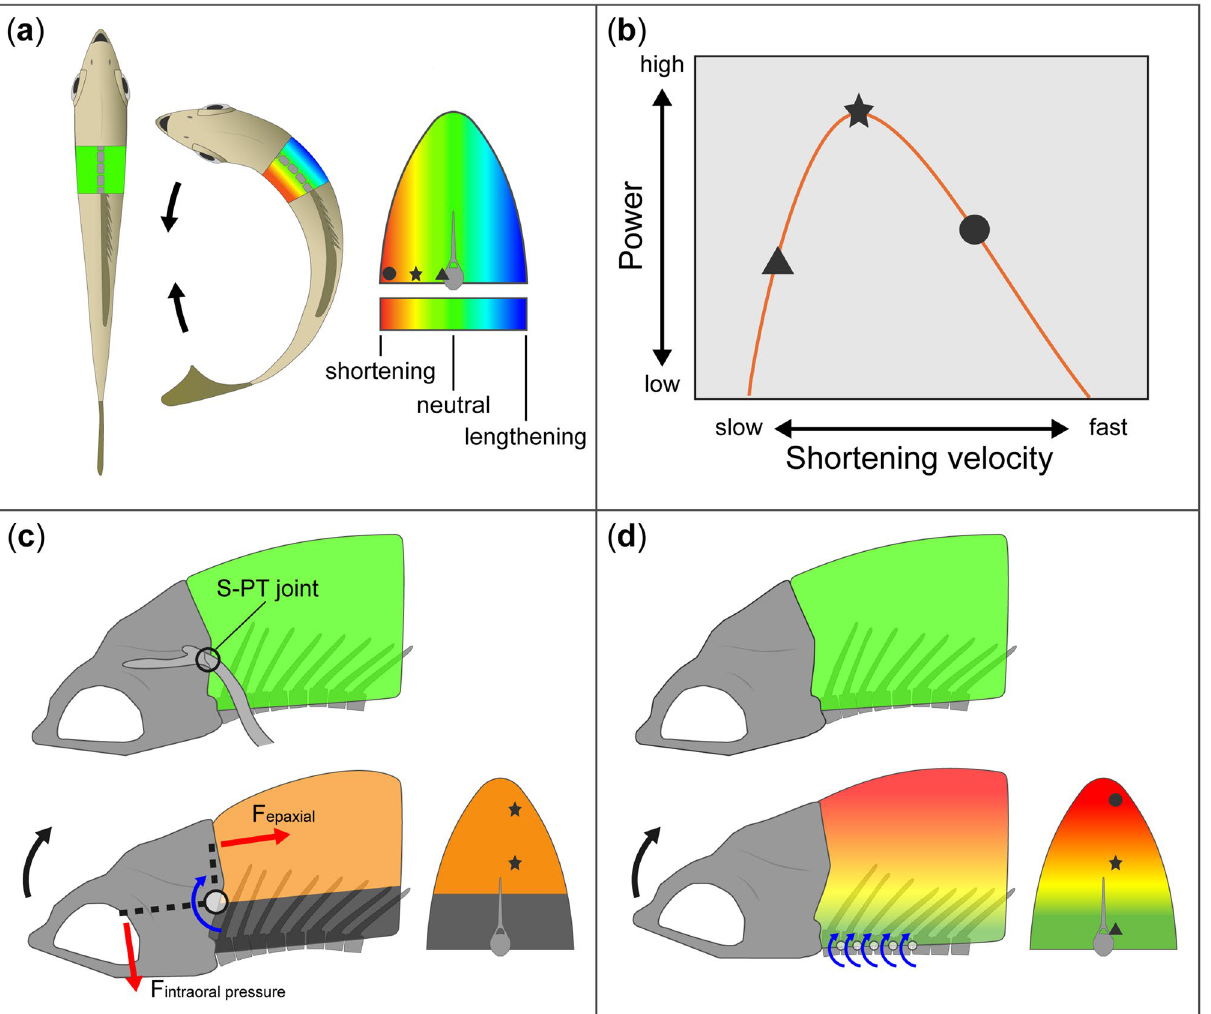
Figure 1. Patterns of longitudinal strain in the epaxial musculature for swimming and suction feeding. ( a ) Axial locomotion: lateral body flexion produces a mediolateral gradient of longitudinal strain in the axial muscle mass. The neutral axis, the vertebral column, undergoes neither shortening nor lengthening. If the muscle fibers were oriented longitudinally, they would also experience this strain gradient. ( b ) A diagrammatic power- velocity curve, illustrating how a gradient of fiber strain rate would affect power production. Muscle shortening velocities in some regions would be faster (circle) or slower (triangle) than those needed for generating maximal power (V opt ), and only some regions (star) would shorten at V opt. ( c , d ) Alternative models of epaxial mechanics in suction feeding. ( c ) The lever model of neurocranial elevation for suction feeding 30 . Epaxial forces acting on the in-lever generate neurocranial elevation, intraoral forces acting on the out-lever resist neurocranial elevation, and the fulcrum occurs at the level of the S-PT joint in the pectoral girdle. Epaxial muscle dorsal to this joint shortens uniformly to produce neurocranial elevation, and therefore could potentially all contract at V opt , but muscle ventral to this joint (dark grey) cannot contribute to cranial elevation. ( d ) An alternative, the beam model of neurocranial elevation for suction feeding, where neurocranial elevation is produced by the dorsiflexion of multiple intervertebral joints. All muscle dorsal to the vertebral column can shorten to produce neurocranial elevation, but the amount of longitudinal shortening is largest in the dorsal region and approaches zero at vertebral column. We test this hypothesis of a dorsoventral gradient in suction feeding in this study. Abbreviation: S-PT, supracleithral and post-temporal of suction feeding performance across species 29–32 . The lever model infers from specimen manipulation that the fulcrum is at the level of a joint within the pectoral girdle and makes the simplifying assumption that the input muscle force acts on a single point of the neurocranium, implying that epaxial muscle shortens uniformly 30 . The lever model is challenged by the finding that neurocranial elevation usually involves dorsal flexion of multiple intervertebral joints, suggesting smooth bending rather than hinge-like rotation occurs 33 . Hence, we hypothesize that suction feeding is powered by beam-like bending that produces a dorsoventral gradient of longitudinal strain in the epaxial musculature, where muscle strain decreases from dorsal to ventral during any given bout of muscle shortening (Fig. 1d).